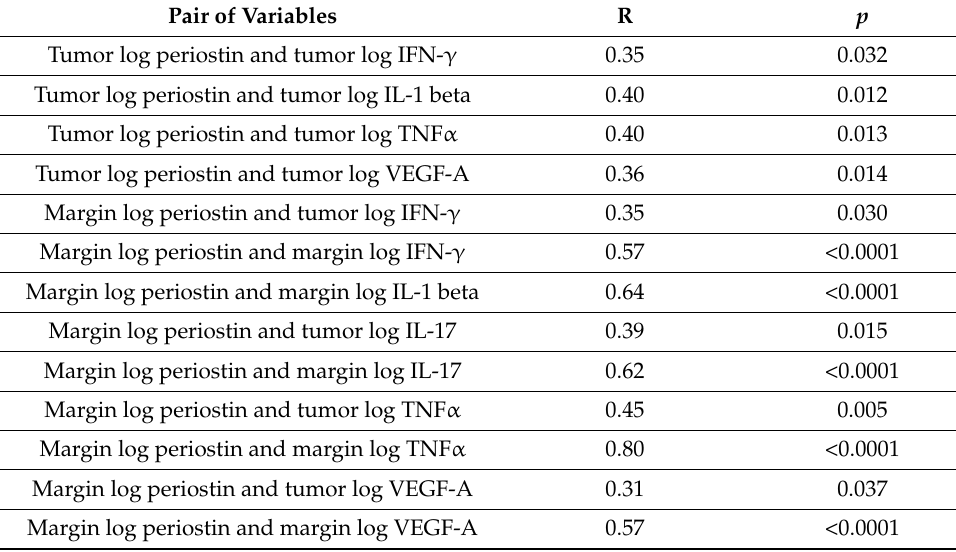
Table 3. Correlations between the periostin levels and the examined molecules. R—Pearson’s correlation coefficient.